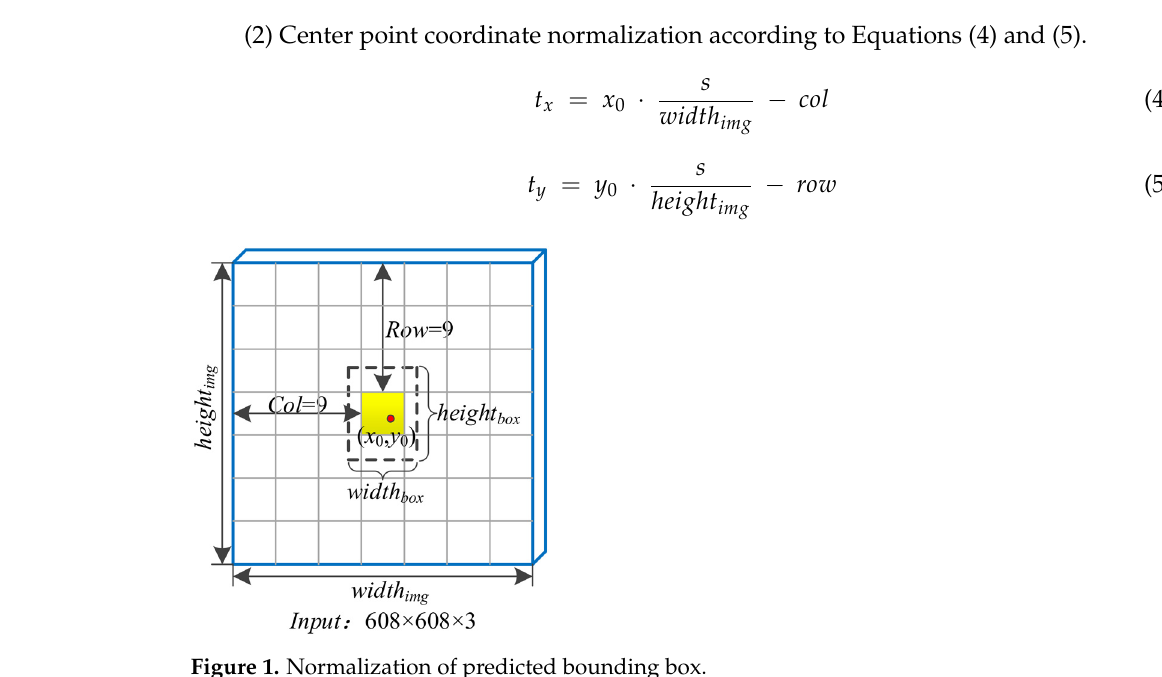
Figure 1. Normalization of predicted bounding box.